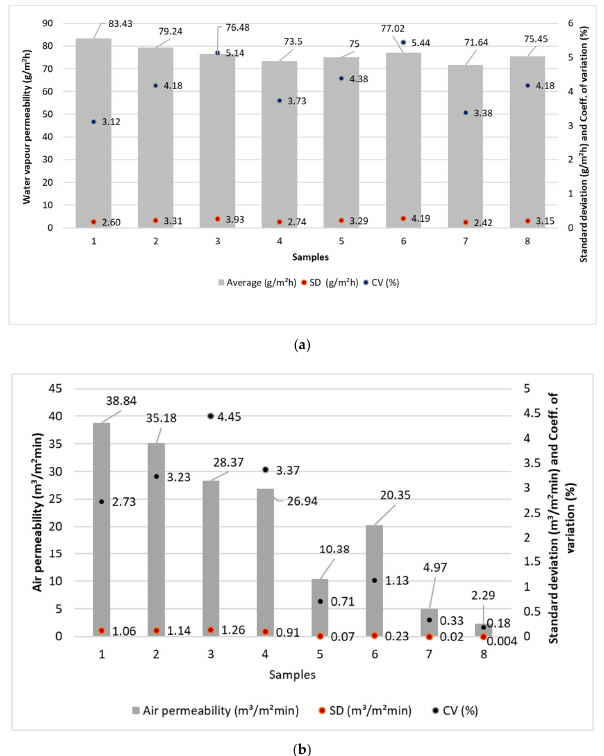
Figure 4. Water vapour permeability ( a ) and air permeability ( b ) of the samples analysed; WVT— water vapour permeability of the samples, g/m 2 h; Q—air permeability, m 3 /m 2 min; SD—standard deviation in g/m 2 h and m 3 /m 2 min; CV—coefficient of variation, %. The results of porosity are listed in Table 5. Table 5. Porosity of the samples.